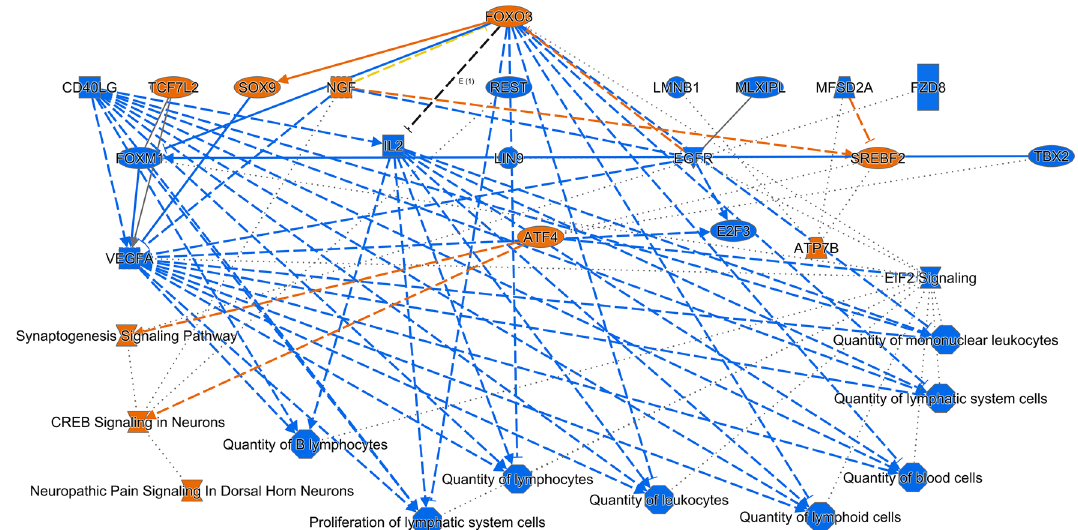
Figure 3. Major biological themes (pathways, upstream regulators, disease and biological functions) obtained from mapping the significantly upregulated DEGs in the spleen of chicks post infection. In IPA, only significantly enriched entities that passed a Fisher’s exact test p-value cut of 0.05 and also passes an absolute z-score cut-off of 2 or greater were visualised. Orange nodes are predicted to be activated (z-score ≥ 2), while blue nodes are predicted to be inhibited (z-score ≥ 2). Blue line: leads to inhibition, orange line: leads to activation green lines: decreased measurement.